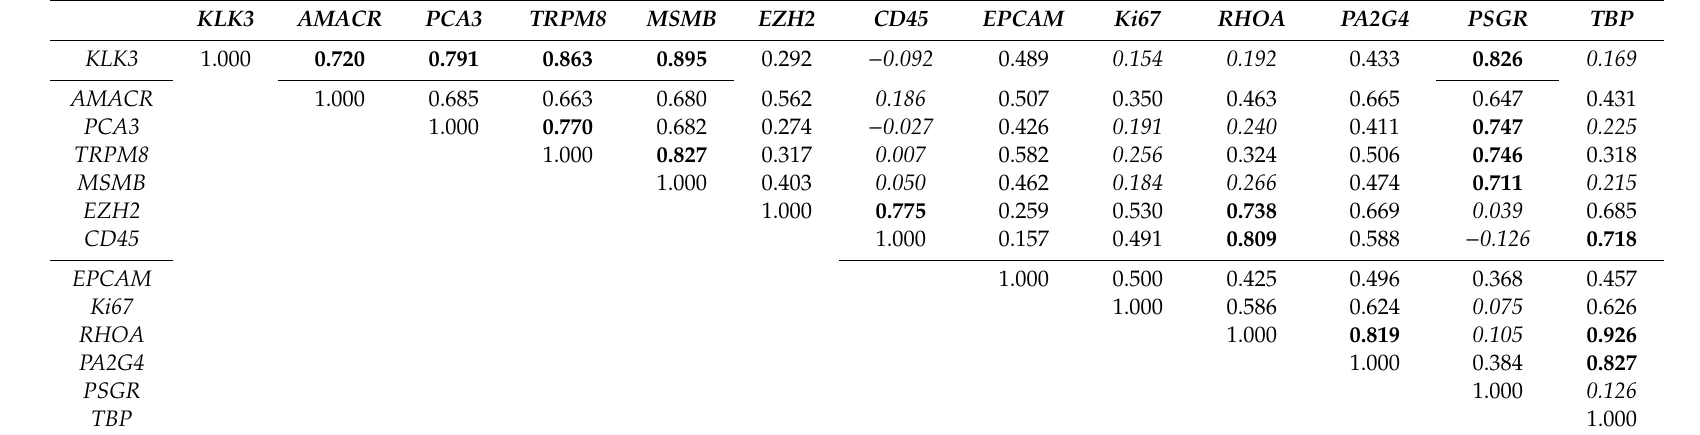
Table 2. Spearman´s correlations between Ct values with emphasis on KLK3 and CD45